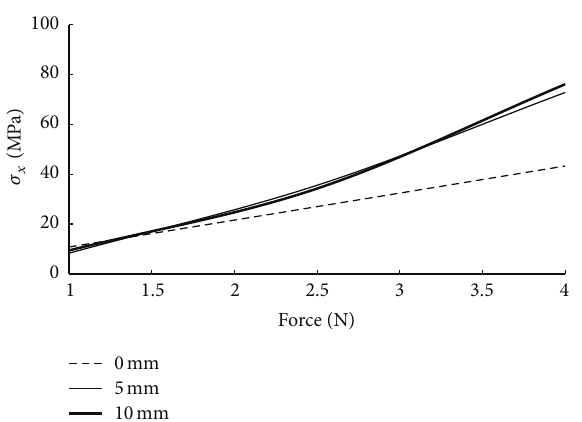
Figure 4: Variation of stress at x -direction for FCR of Model II under the position angle of 34 ∘ .